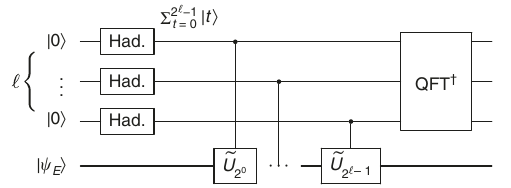
Fig. 2 The familiar quantum circuit of Shor ’ s algorithm. If the input state is replaced by an eigenvector of U N , y , ψ φ with eigenvalue φ , then the output is an exponentially accurate estimation of φ , implying an equally good estimation of the corresponding eigenvalue of H N , y . This reasoning holds with any unitary e − iHt instead of U N , y , hence ef fi cient simulation of e − iHt for exponential t implies exponential cTEUR violation of H . This gives the seed